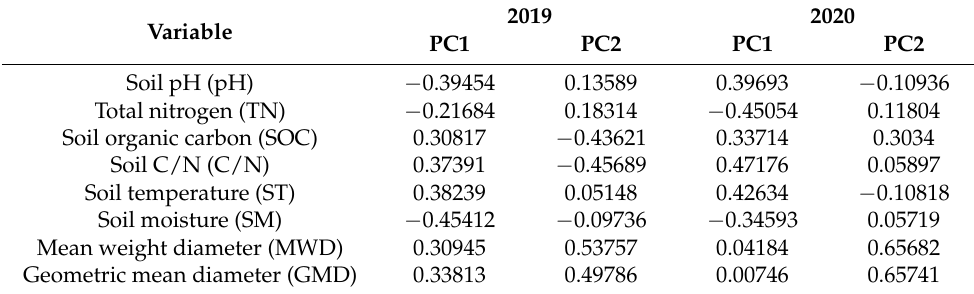
Figure 6. Principal component analysis (PCA) of different environmental factors. ( A ) represents the PCA in 2019, ( B ) represents the PCA in 2020. Abbreviations: Soil pH (pH); Soil organic carbon (SOC); Total nitrogen (TN); Soil C/N (C/N); Soil temperature (ST); Soil moisture (SM); Mean weight diameter (MWD); Geometric mean diameter (GMD). Table 3. Results of the principal component of the soil quality